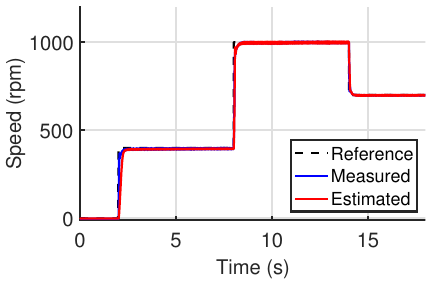
Figure 24. Experimental results of the proposed observer at variable